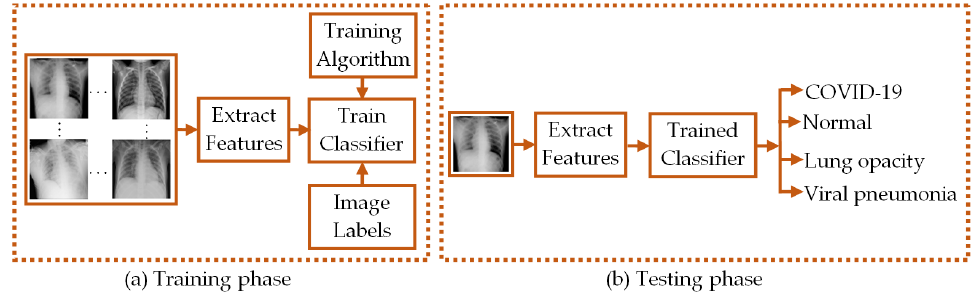
Figure 1. Functional diagram depicting the ( a ) training and ( b ) testing phases of classifiers.